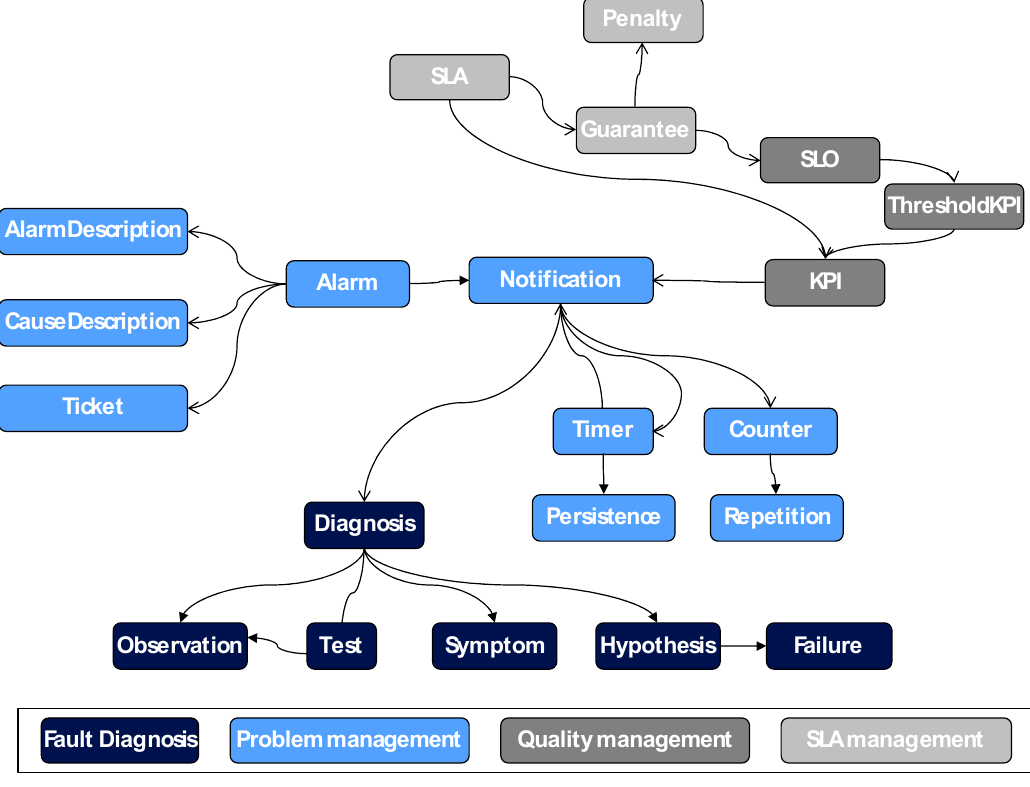
Figure 2. Whole management ontology.